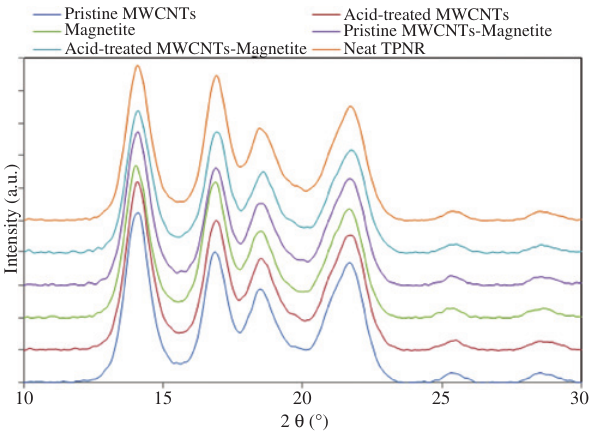
Figure 4 WAXS patterns of the neat TPNR and its